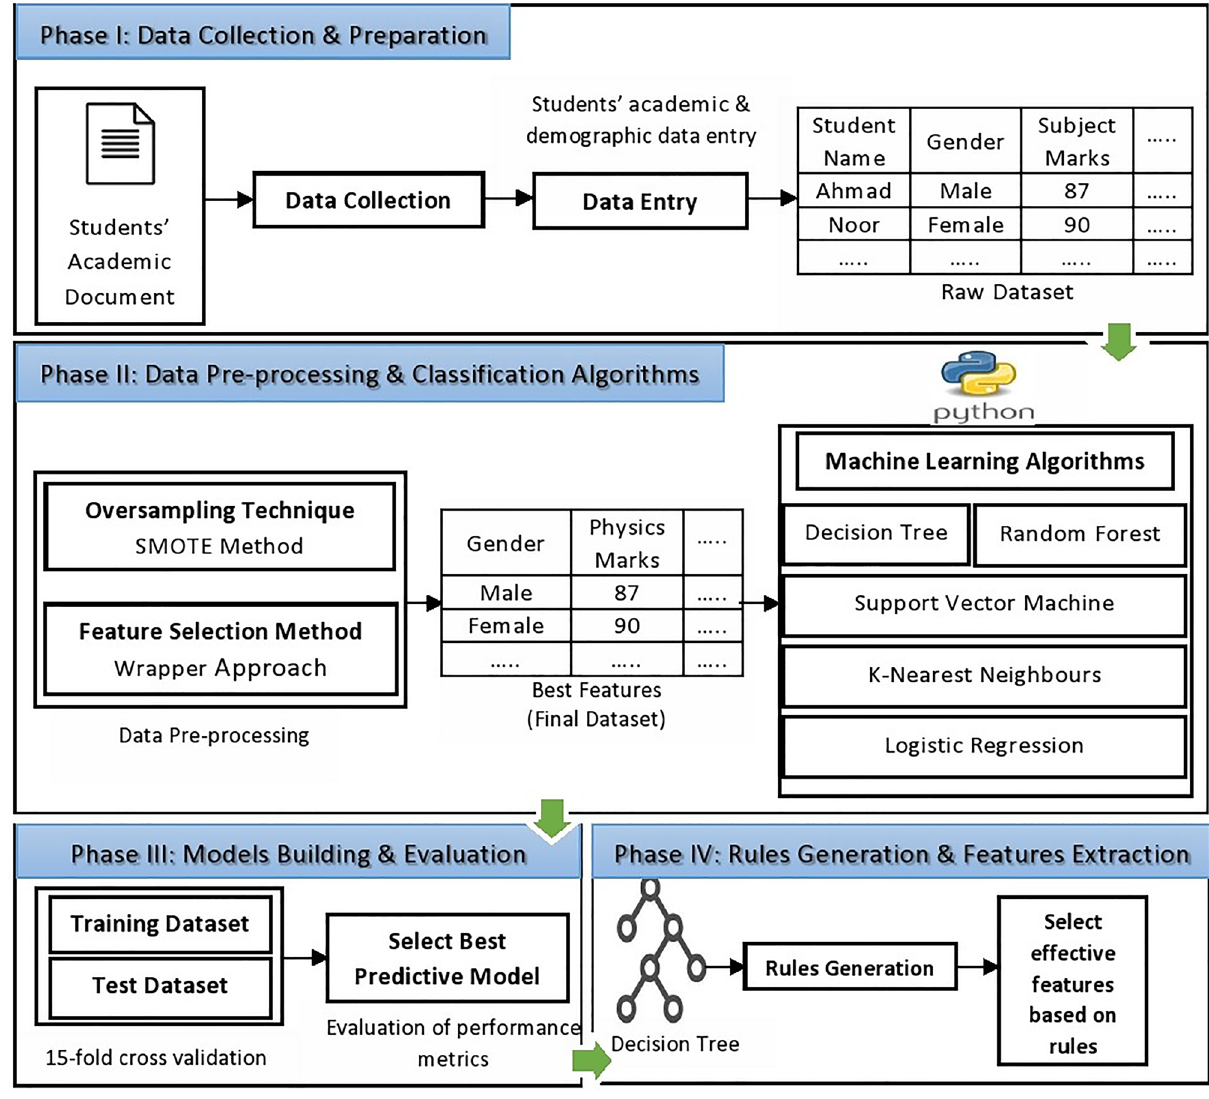
Figure 1. Proposed approach for student performance prediction and feature